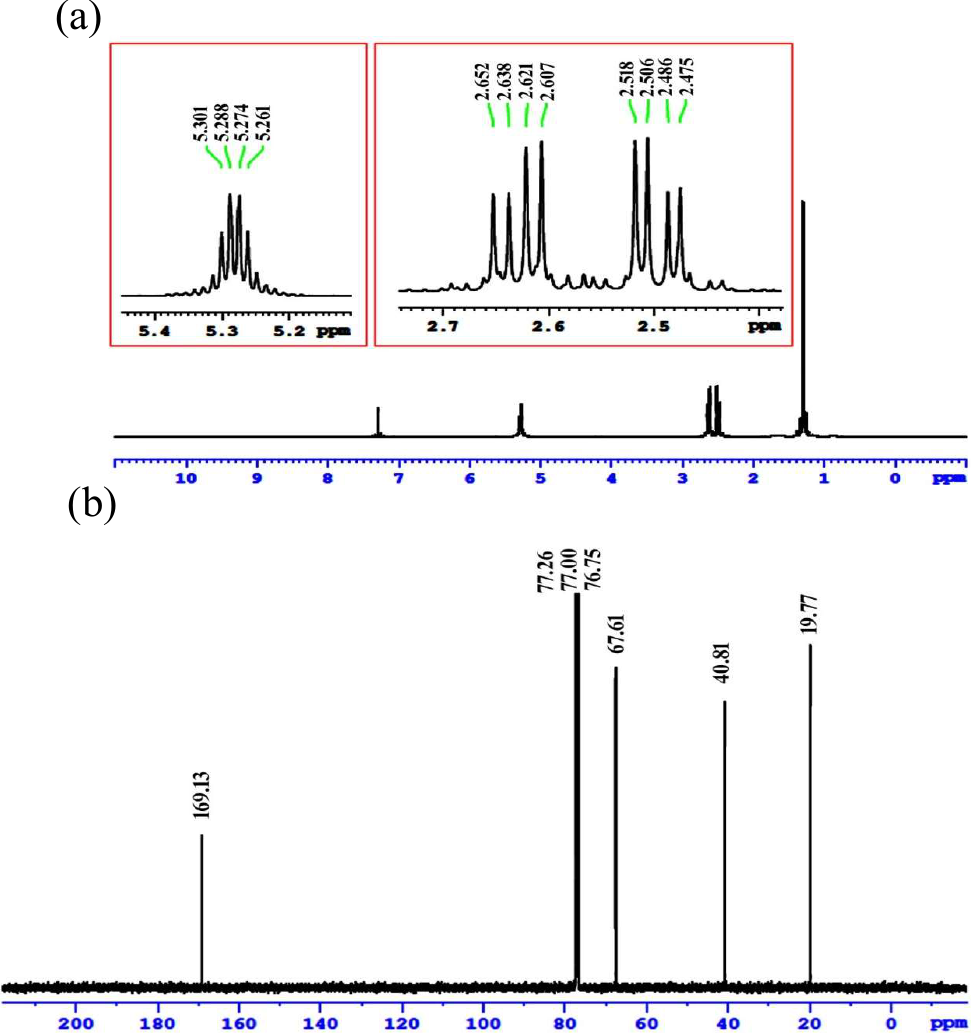
Figure 12. Nuclear Magnetic Resonance (NMR) analysis of PHB extracted from E. aquimaris . ( a ) 1 H NMR spectrum of PHB shows signals at chemical shift δ 1.31 (d, CH 3 ,), 2.472 (q, CH 2 ,), and 5.26–5.30 ppm (m, CH,). ( b ) 13 C NMR spectrum of PHB shows signals at 169.13, 67.61, 40.81, and 19.77 ppm for carbon atom of CO, CH, CH 2 , and CH 3